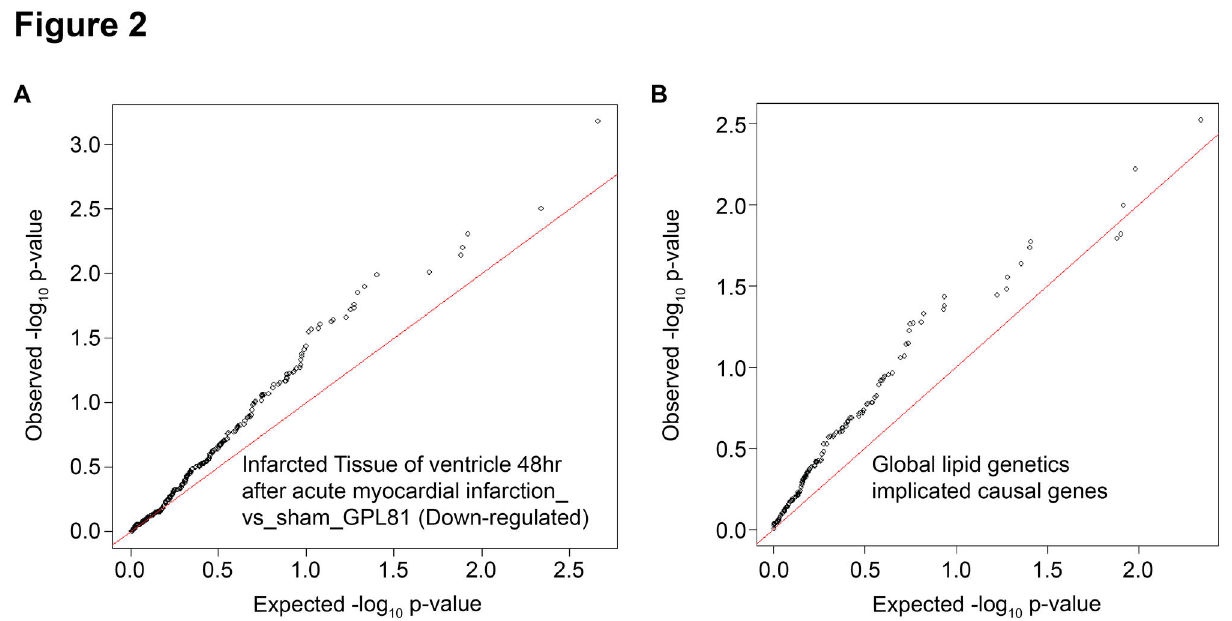
Figure 2. Quantile-Quantile(QQ) plots on SNP set enrichment. QQ-plots of SNP set enrichment test. Solid line represents normal distribution and black dots represent data distribution of p-values for eSNPs representing genes within the gene set of interest. Deviation of the data from the solid line indicates a non-normal distribution. Plots are shown for the top ranking gene sets A: published mRNA profiling signatures from infarcted tissue and B: implicated causal genes from the Global Lipid Genetics GWAS Consortium.